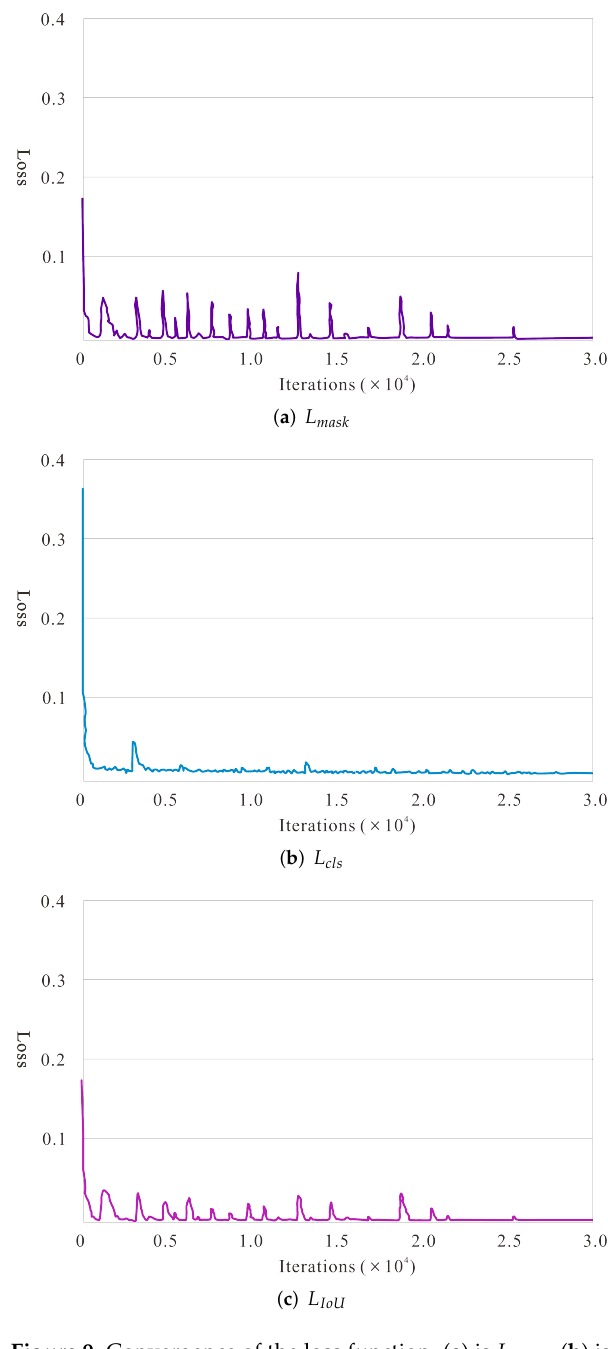
Figure 9. Convergence of the loss function. ( a ) is L mask , ( b ) is L cls , and ( c ) is L IoU